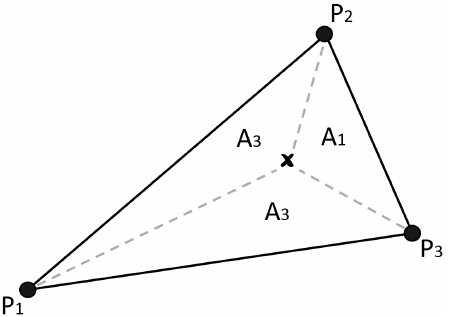
Figure 2. An illustration of the TIN interpolation technique at point x . In this case, point w lies within a triangle formed by points P 1 , P 2 and P 3 . The weight of each point is calculated based on the corresponding area. For example, P 1 has the weight of A 1 ∑